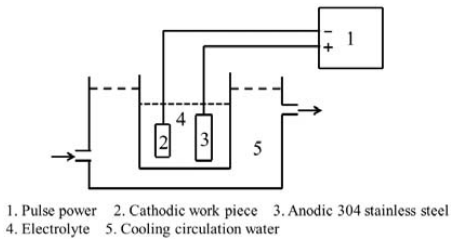
Figure 2. Schematic view of the cathodic plasma electrolytic deposition (CPED) system.